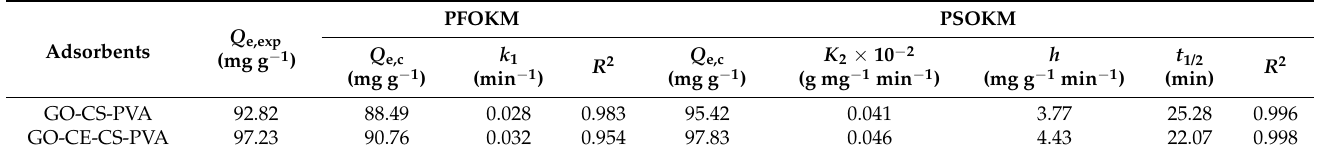
Table 1. PFOKM and PSOKM parameters of GO–CE–CS–PVA and